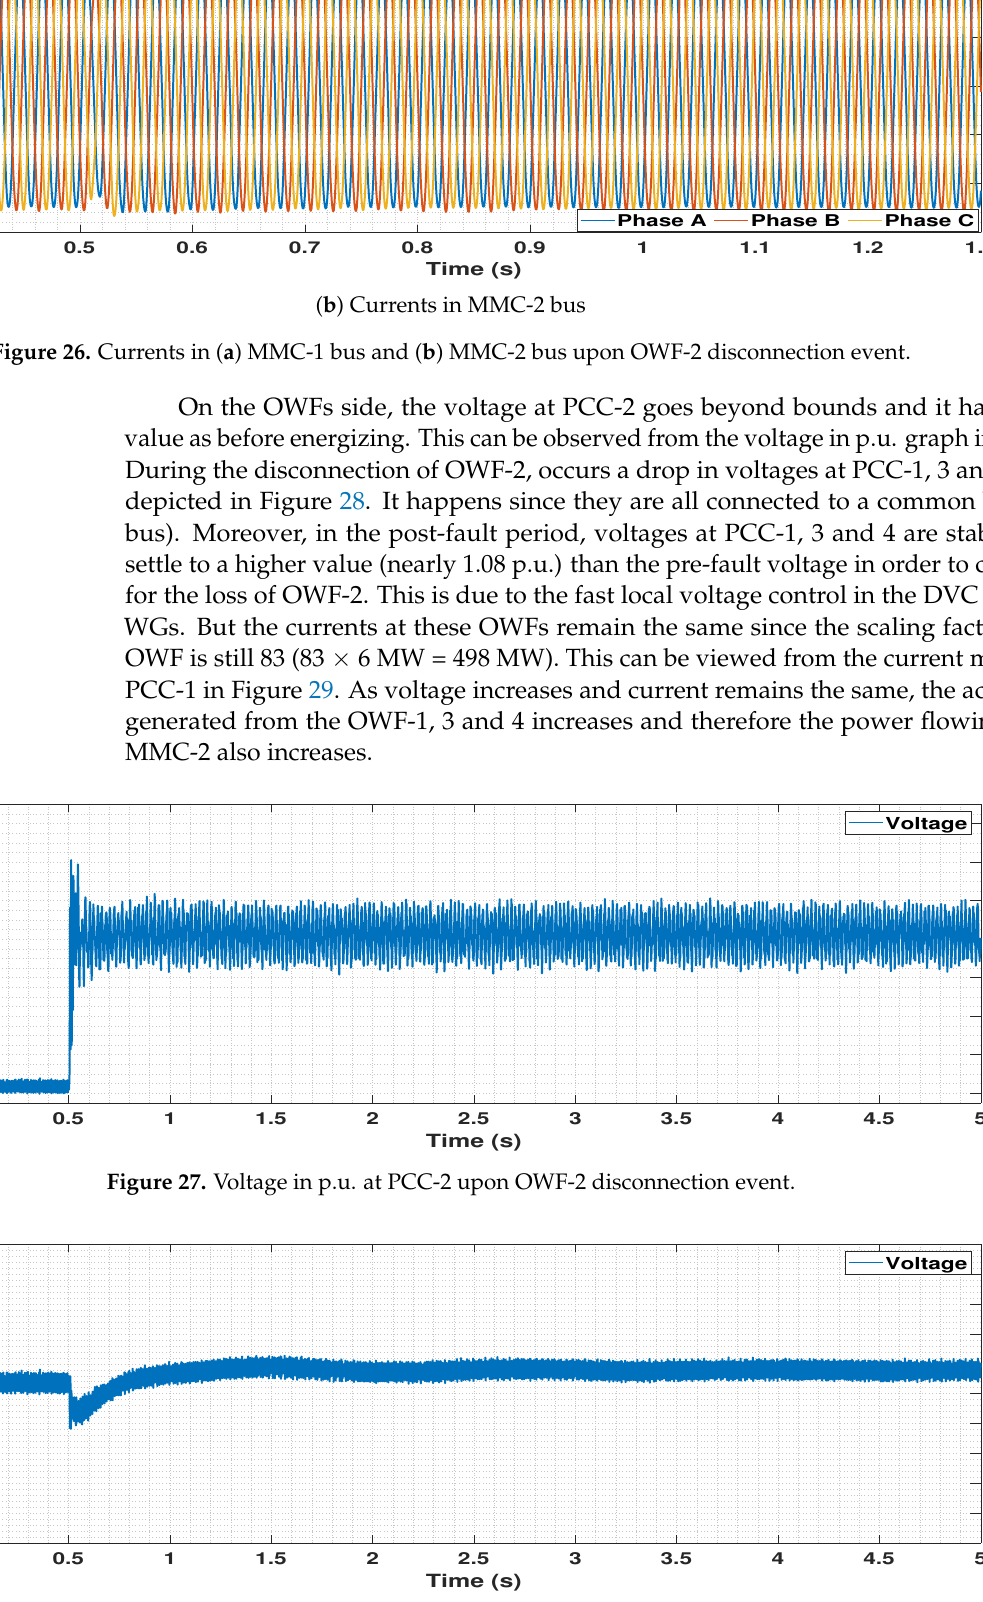
Figure 28. Voltage in p.u. at PCC-1 upon OWF-2 disconnection